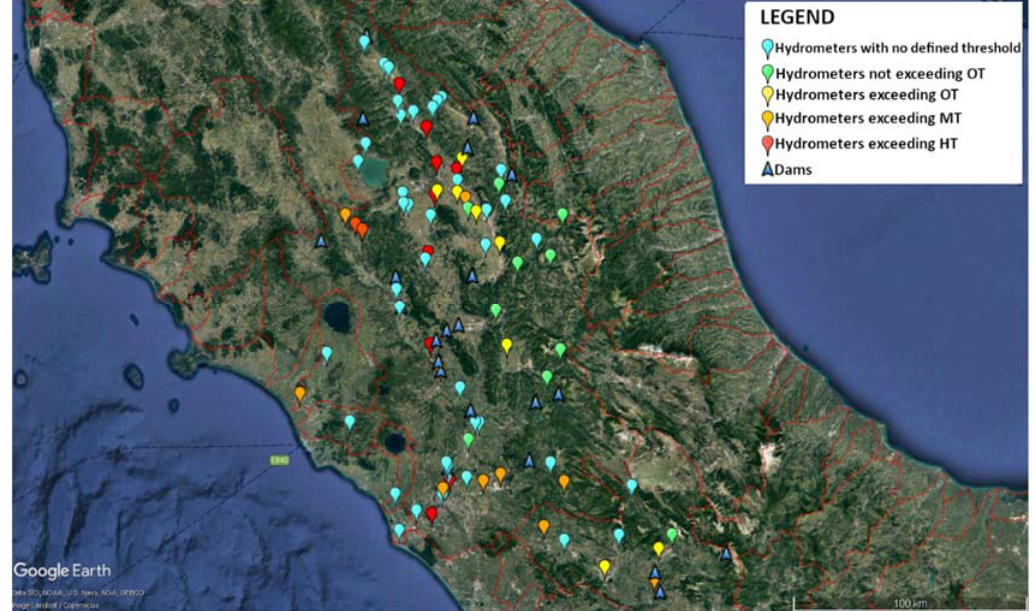
Figure 6. Geographical location of dams and hydrometric sensors. Gauge pinpoints are colored according to their critical status. Red lines indicates main basins boundaries. For a better and interactive visualization, a. kmz file, named “Domain.kmz” is provided with the Supplementary Material.